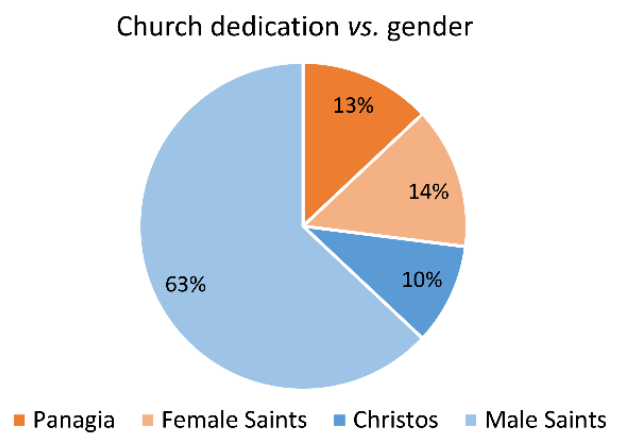
Figure 14. A pie chart showing the percentage of post-medieval churches dedicated to Mary, other female saints, Christ and male saints on the island of Paros (data and graph by the author).